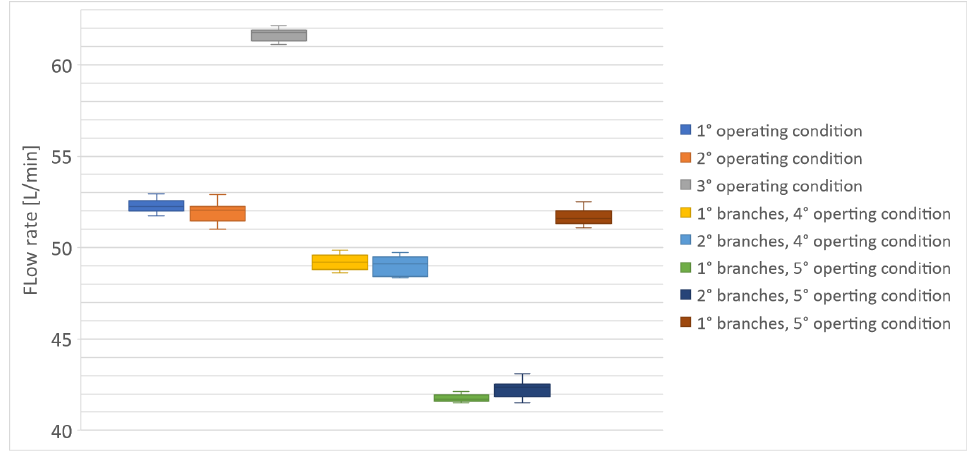
Figure 9. Box plots of the experimental measurements. Number of tests repeated for each case: 10.